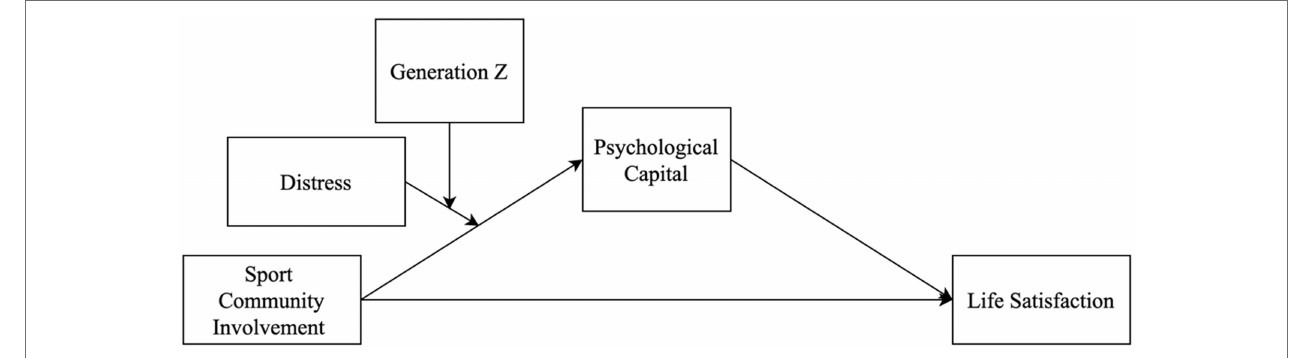
FIGURE 1 | Research model.